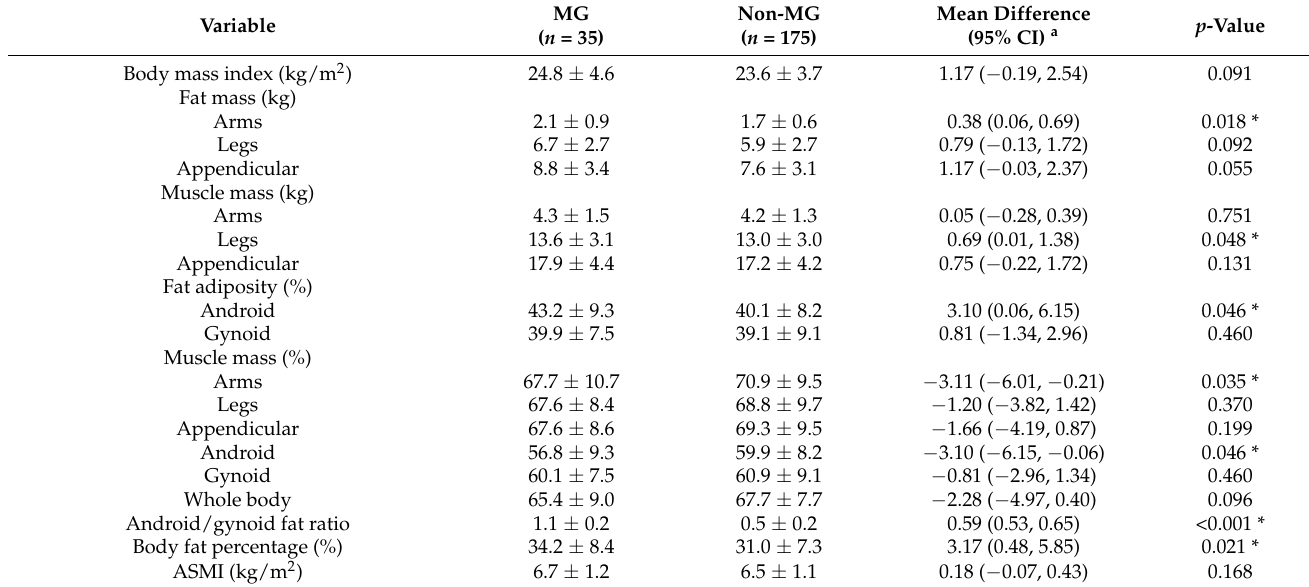
Table 2. Body composition in patients with MG and sex- and age-matched controls.